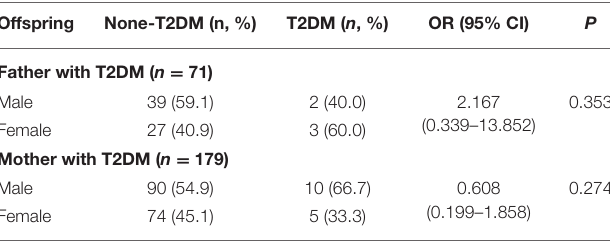
TABLE 3 | The prevalence comparison of T2DM among male and female offspring.